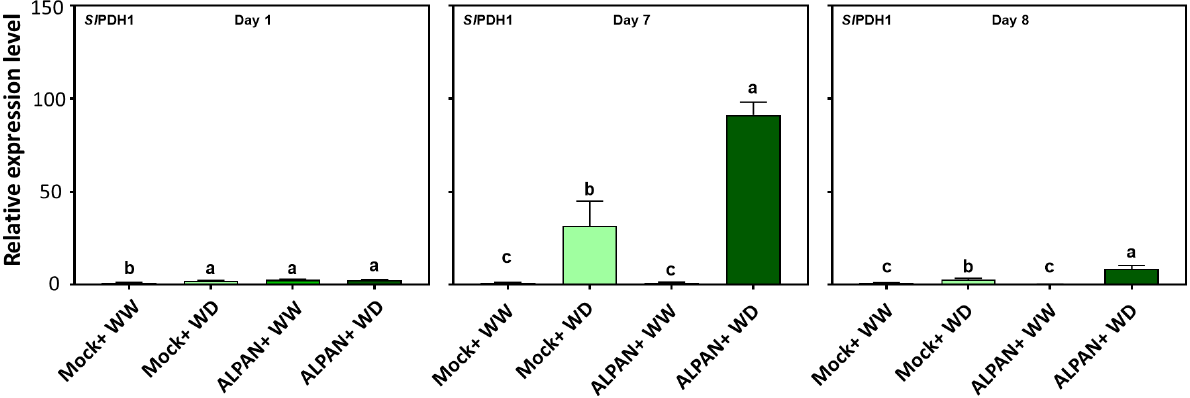
Figure 7. Expression levels of SlPDH1 after 1, 7, and 8 days of the initiation of the water deficit stress. WW = well watered, WD = water deficit. Error bars represent the standard deviation of four independent biological replicates in each experimental group at each sampling timepoint. The statistical data were analyzed with the use of the one-way ANOVA and Tukey’s post hoc tests, and a statistically significant difference ( p -value < 0.05) is denoted by a different letter above a histogram